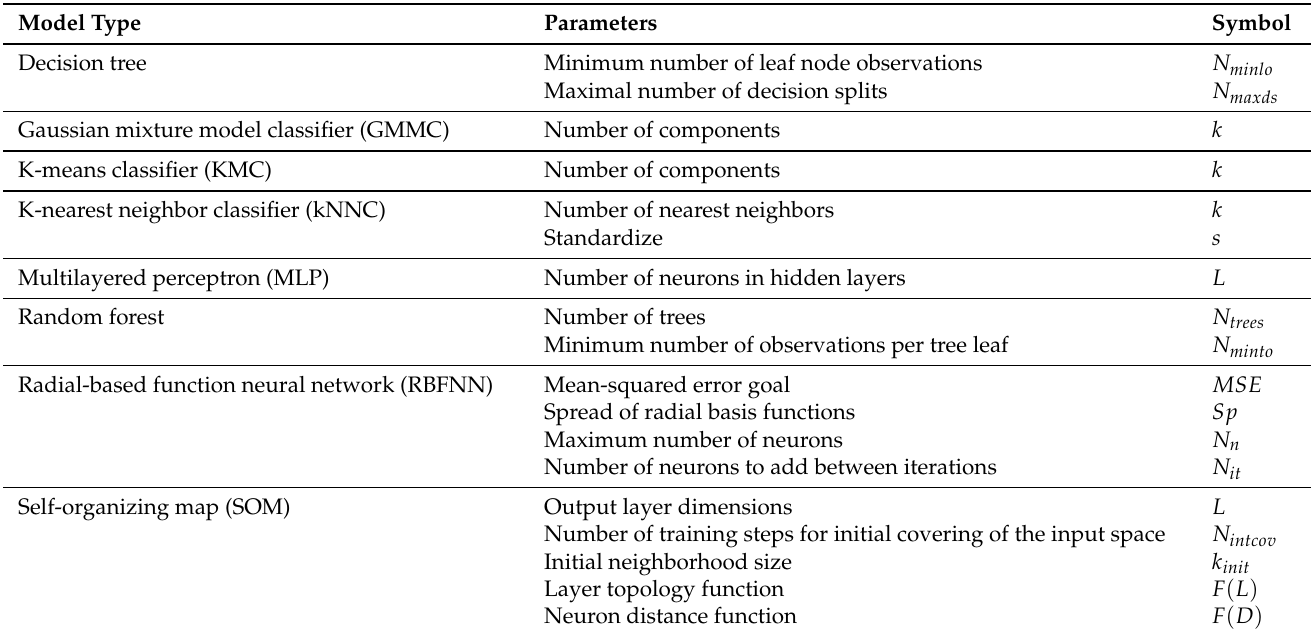
Table 3. Model types and